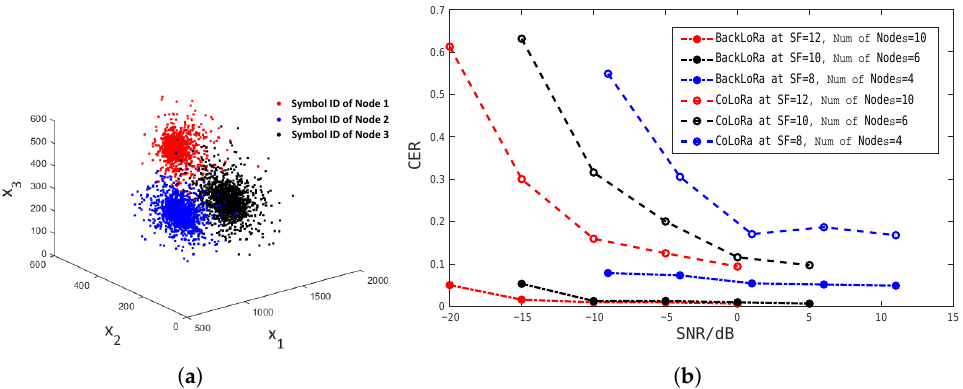
Figure 9. ( a ) Symbol IDs from different nodes at SNR from − 20 dBm to 10 dBm. ( b ) Classification performance at different conditions compared with CoLoRa.